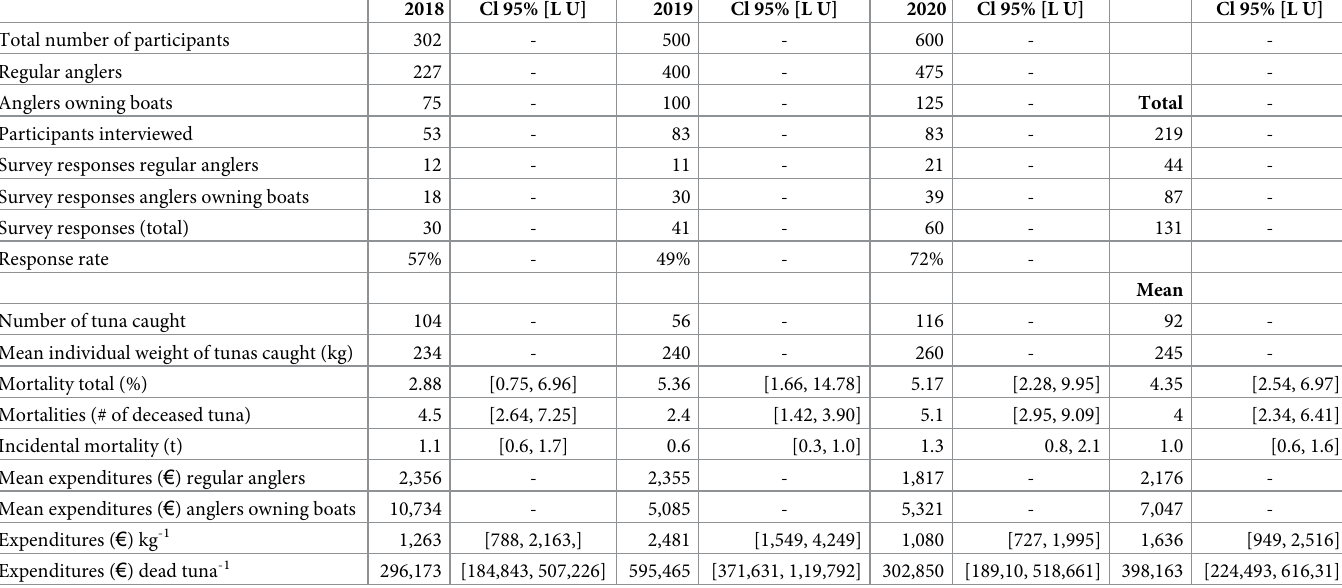
Table 2. Key results of the from the survey of ABFT anglers from 2018–2020 including total numbers of participants in the ABFT fishery in the categories of regular anglers and anglers owning boats. Mean and total annual expenditures in Euro for regular anglers and anglers owning boats with lower and upper [L U] 95% Confidence limits (Cl) for expenditures based on the mortality estimates derived according to Clopper and Pearson (1934) [36]. Mortality includes both immediate and post-release